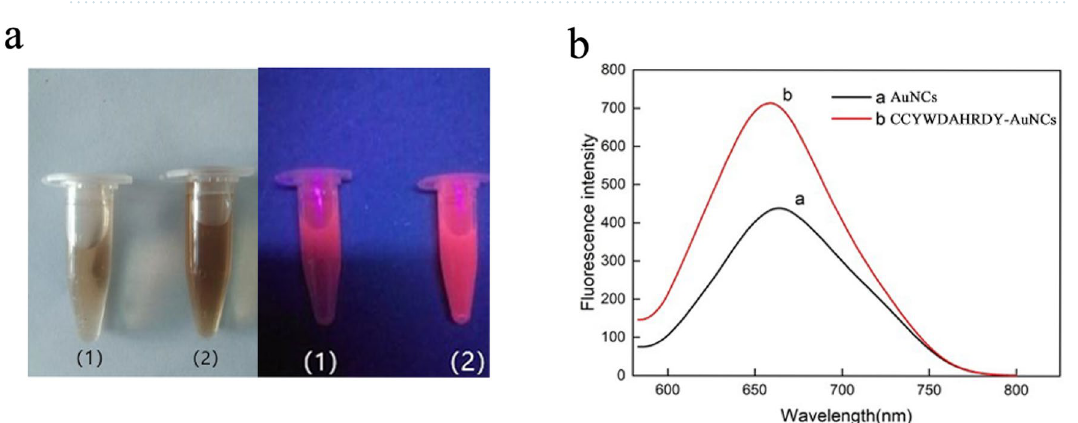
Figure 3. The fluorescence intensity of AuNCs and CCYWDAHRDY-AuNCs: ( a ) Photographs of the AuNCs (1) and the CCYWDAHRDY-AuNCs (2) in daylight (left) and under a 350 nm UV lamp (right), ( b